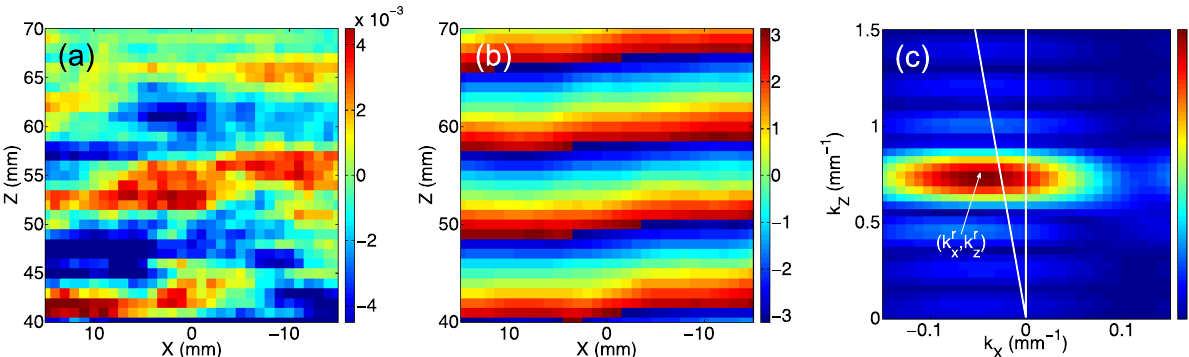
Figure 2. ( a ) Snapshot of the measured pressure field refracted from the prism filled with concentrated metafluid (